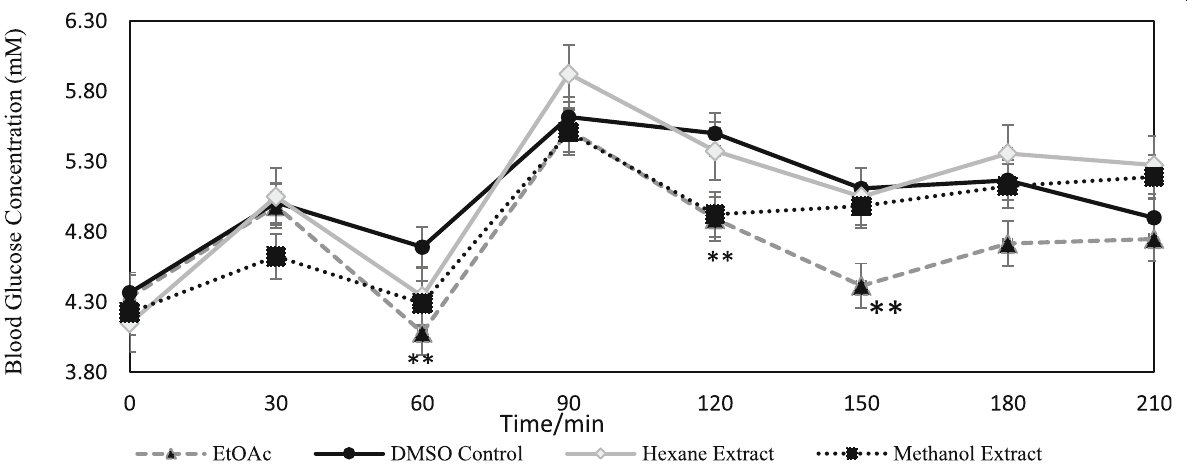
Fig. 2 The effects of the crude extracts of Desmodium canum (Strong Back) on blood glucose levels in normal Sprague-Dawley rats (IV @ 50 mg/ kg BW). ** p <